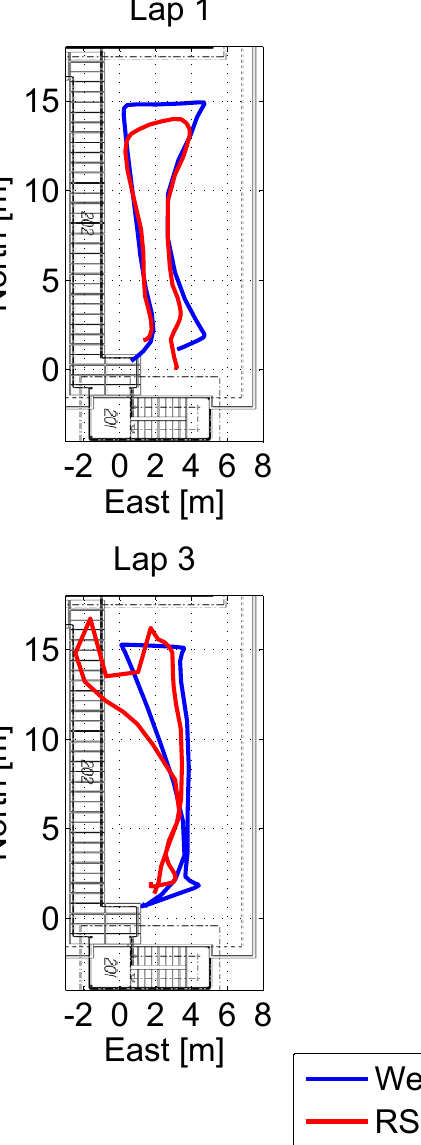
Figure 16. Trajectories obtained considering the weighted centroid (WeC) and RSS approaches for the four laps performed by the user.